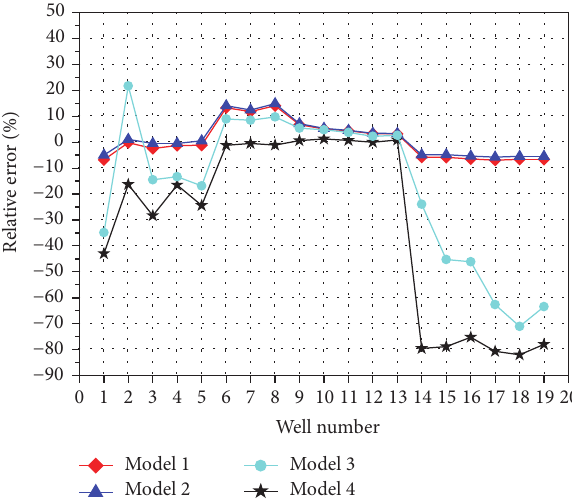
Figure 5: Relative errors of calculated